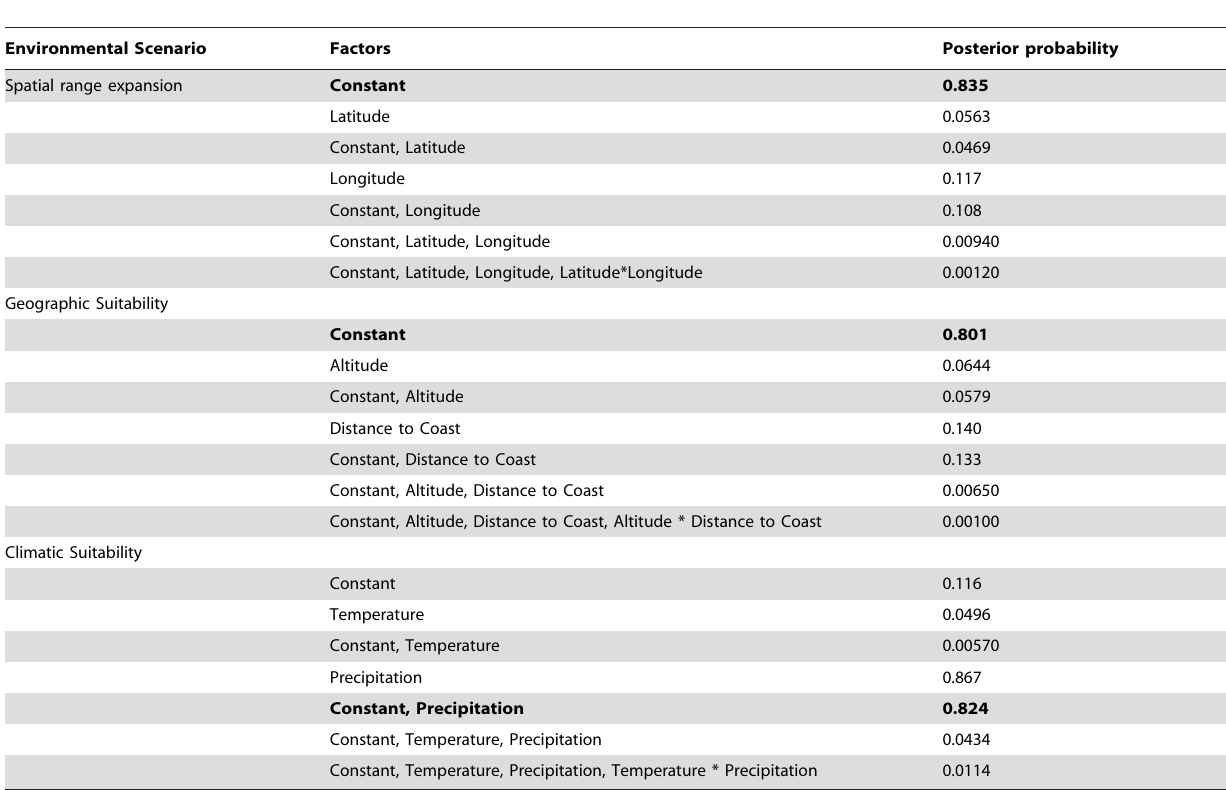
Table 6. Posterior probabilities for different models (2 factors with their interaction) under the three environmental scenarios from the GESTE analysis.